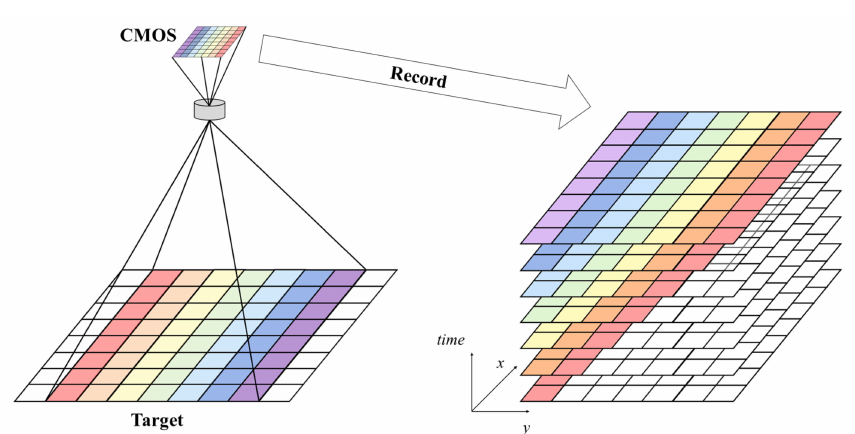
Figure 2. The schematic of the spatio-tempo hybrid